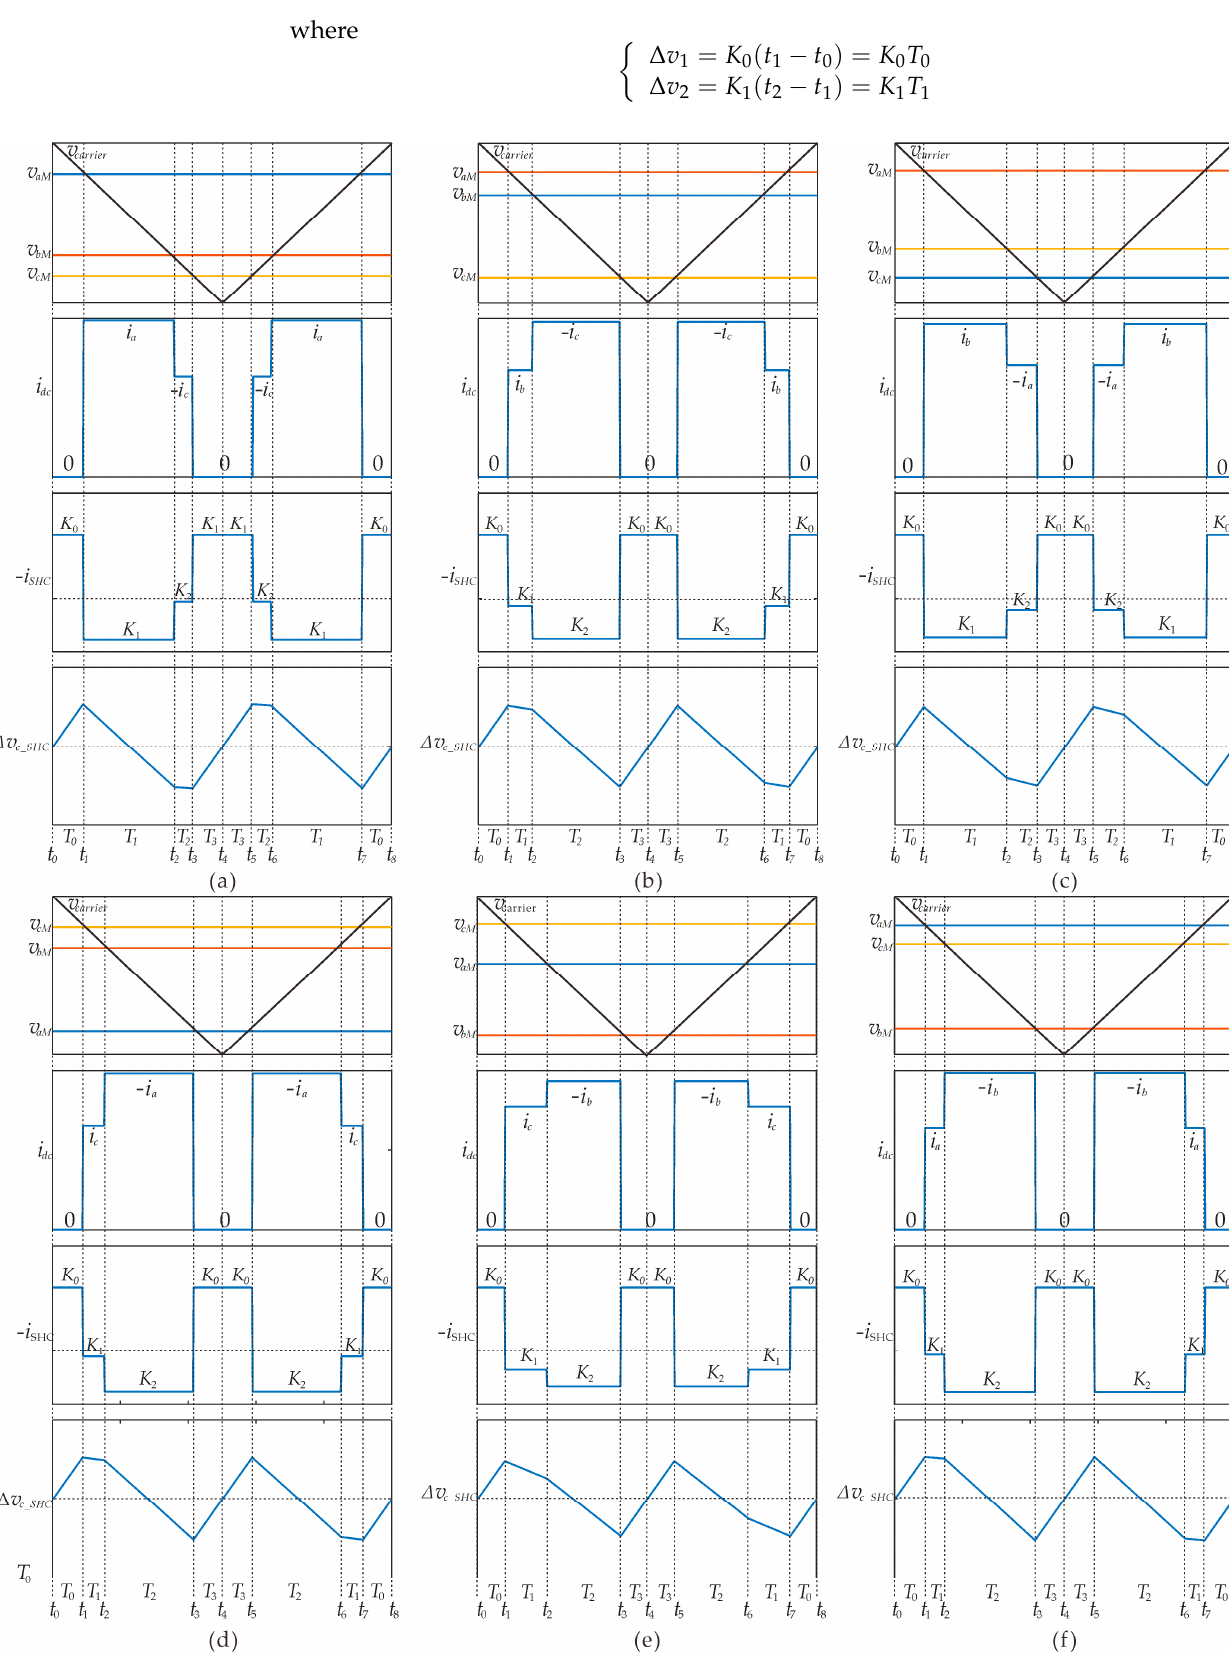
Figure 3. The SHV ripple in dc-link over one switching period: ( a ) Sector 1; ( b ) Sector 2; ( c ) Sector 3; ( d ) Sector 4; ( e ) Sector 5; ( f ) Sector 6.